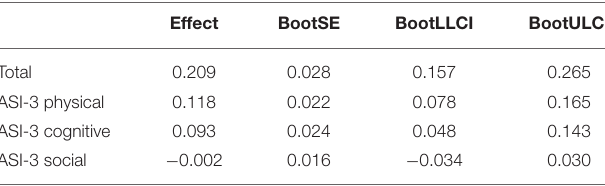
TABLE 7 | Analysis of the mediating effect of physical, cognitive and social concerns on negative bias affecting